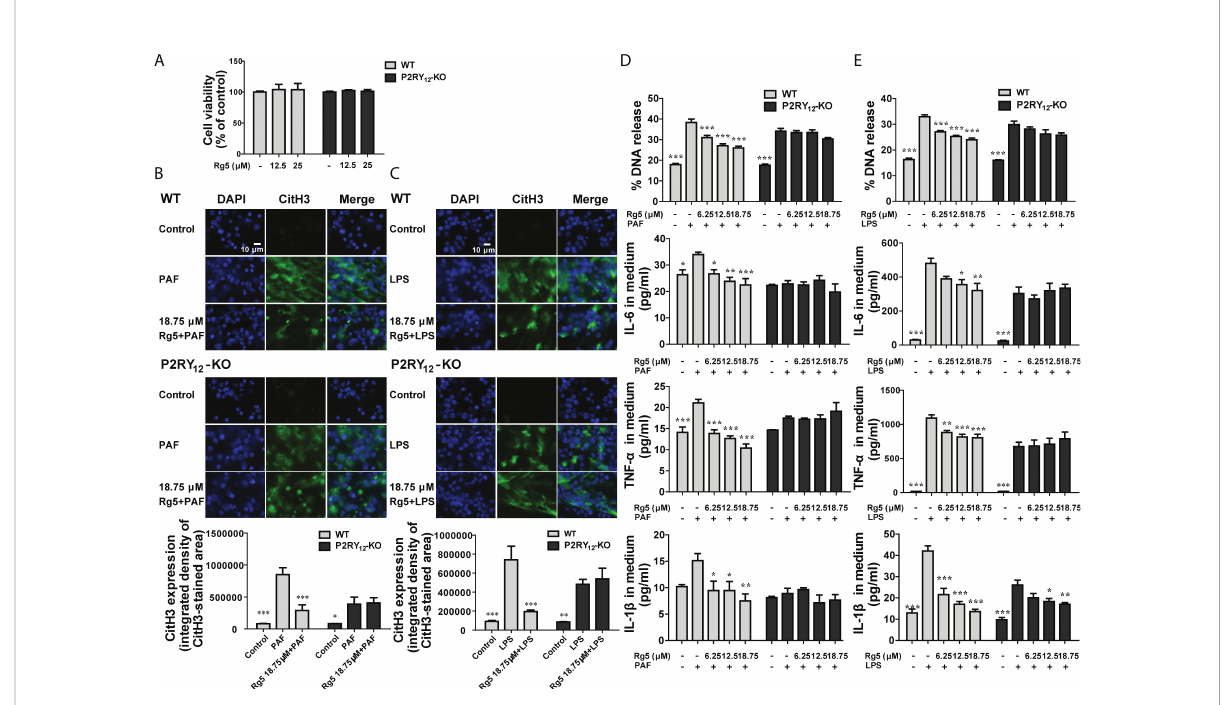
FIGURE 5 Effects of Rg5 on PAF or LPS-induced release of NETs and in fl ammatory factors in WT or P2RY 12 -KO neutrophils. (A) Effect of Rg5 on WT or P2RY 12 -KO neutrophils viability (n = 4). (B, C) Immuno fl uorescent staining and statistical analysis of CitH3 in WT or P2RY 12 -KO neutrophils stimulated by PAF or LPS. (n = 6). (D, E) DNA concentration (n = 4) and IL-6, IL-1 b , and TNF- a concentrations (n = 4) in the medium of WT or P2RY 12 -KO neutrophils stimulated by PAF or LPS. All the data are shown as the mean ± SEM. * P < 0.05, ** P < 0.01, *** P < 0.001 vs. PAF or LPS